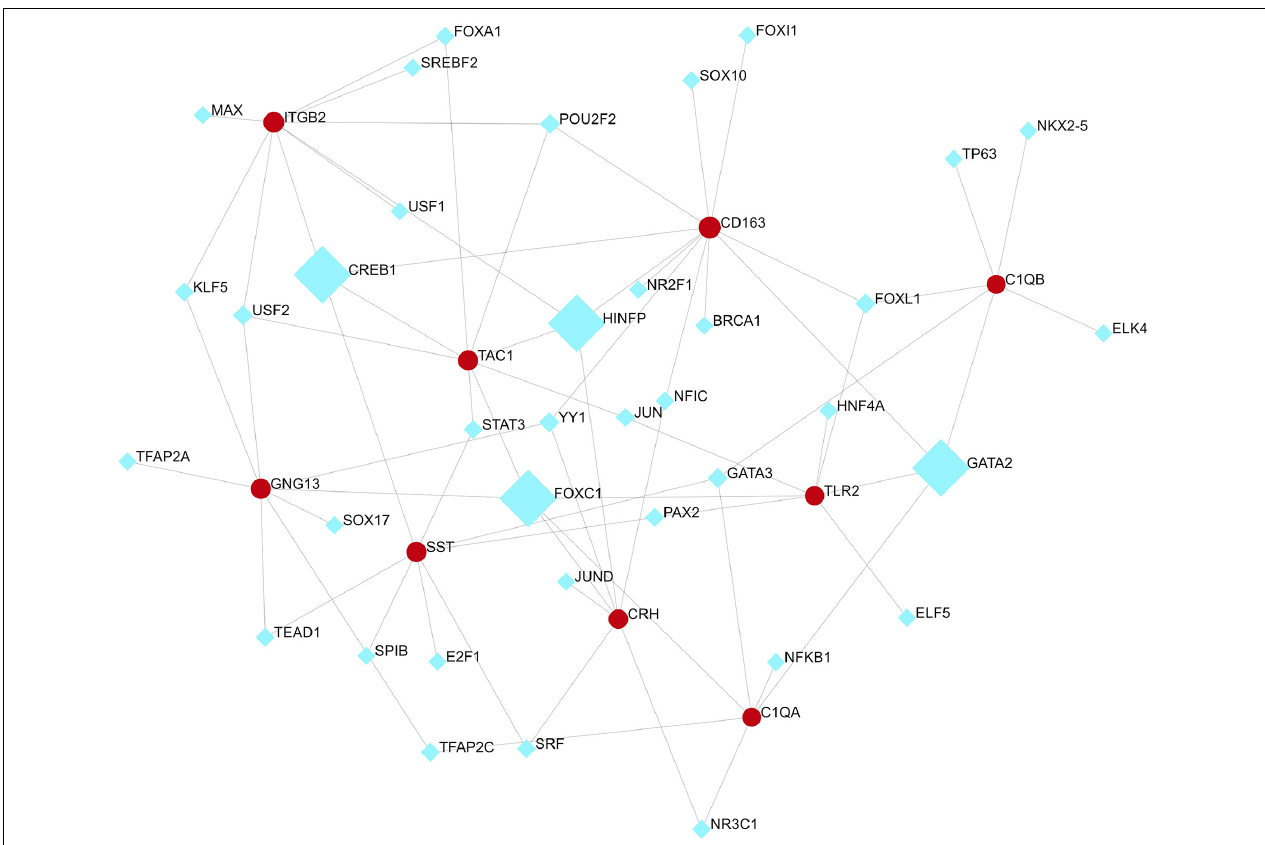
FIGURE 6 | Hub gene–transcription factor interaction network. Medium confidence score was used to construct the network.